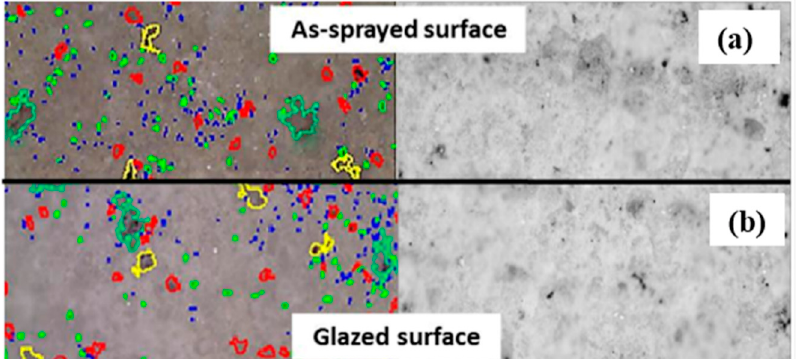
Figure 6. Optical microscopic images of surfaces of: ( a ) as-sprayed and ( b ) laser-glazed FG-TBC. In the right-hand side images, pores appear in grey/black colours. The left-hand side pictures are from the image analysis of the respective optical microscopic images, in which different colours represent pores of different size.